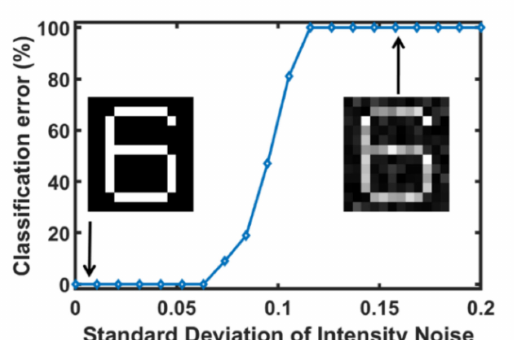
Figure 9. PSCNN classification error for different values of the intensity noise. The intensity noise is drawn from a normal distribution whose standard deviation is expressed as a percentage of the nominal input power P IN = 0.2 mW ( x -axis). For intensity noise values up to 6% (12 µ W) no classification error is monitored. However, for higher values of intensity noise there is a sharp increase in network’s classification error and for a standard deviation of 11% (22 µ W) the system collapses since it cannot classify the input images. In this figure, digit ‘6 (cid:48) is presented as an indicative example of the intensity noise’s impact. The left image of digit ‘6 (cid:48) represents the case of no intensity noise while the right one corresponds to an intensity noise of